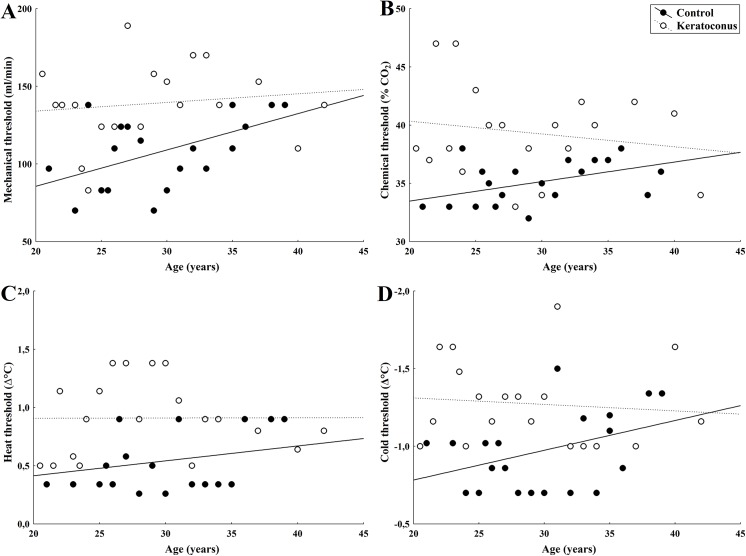
Relationship between age and corneal sensitivity threshold to mechanical (A), chemical (B), heat (C), and cold (D) stimulation in KC patients and in control subjects.Regression lines (solid: control; dotted: KC) are also plotted (see text for details on R coefficients and P-values).